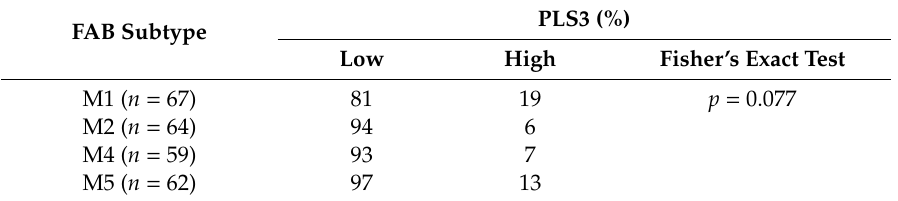
Table 1. Distribution of low vs. high PLS3 expressors in di ff erent FAB